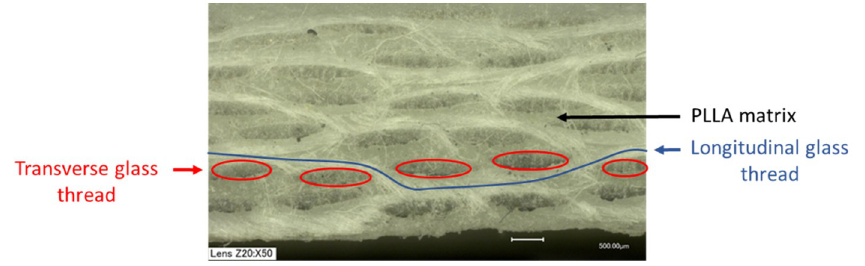
Figure 3. Optical microscopy picture of PLLA matrix composite (run 15).